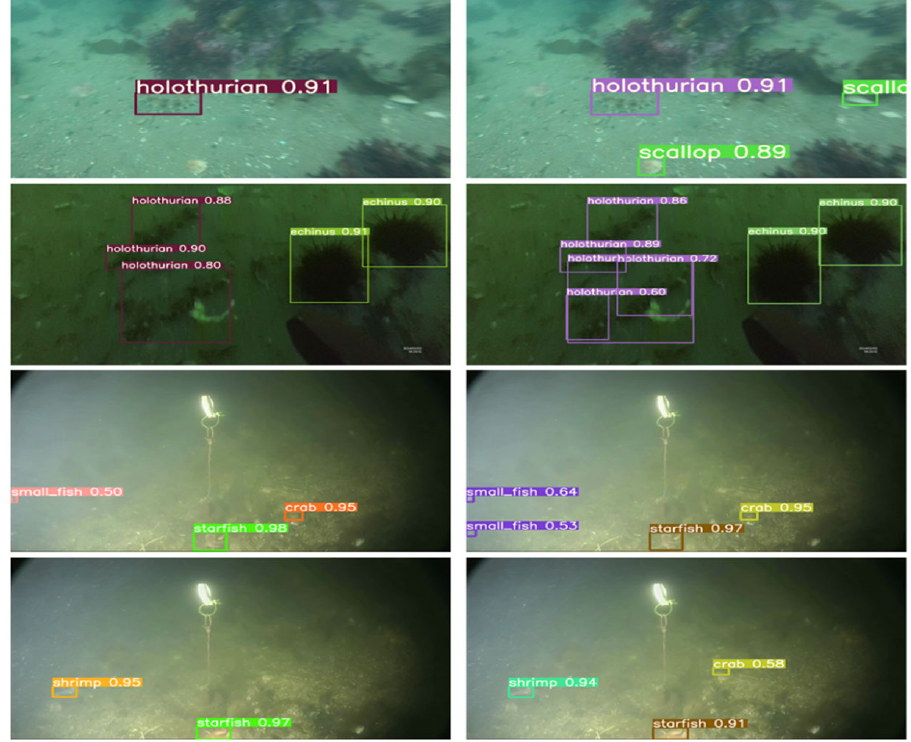
Figure 15. Detection results of YOLOv7 ( left ) and YOLOv7-AC ( right ) in harsh underwater scenes.